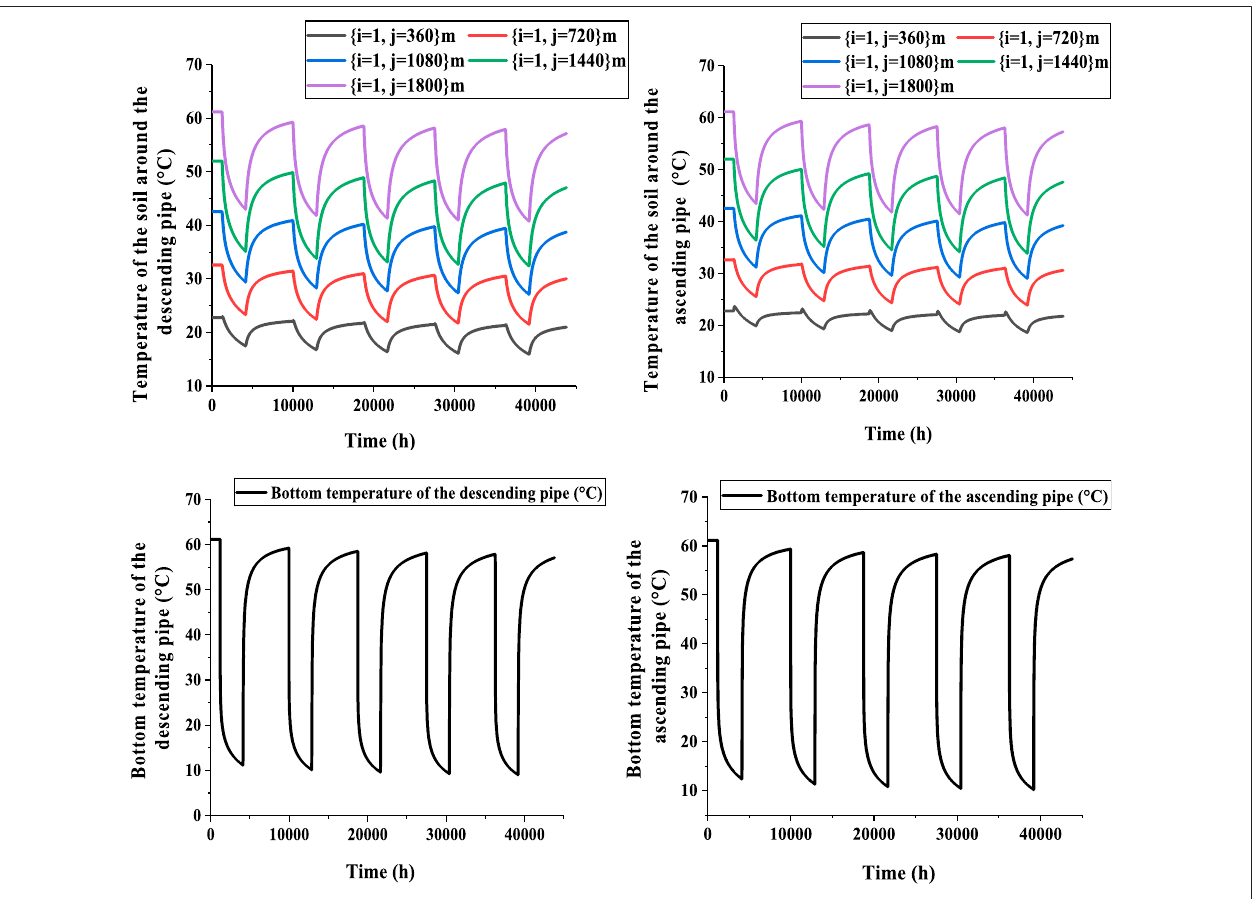
FIGURE 7 | Changes in temperature around and at the bottom of the vertical pipe.